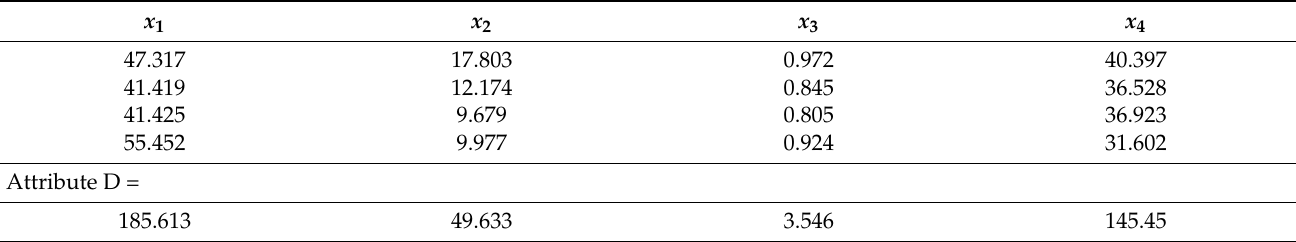
Table 7. Values of “Attribute D” of four air pollutants.